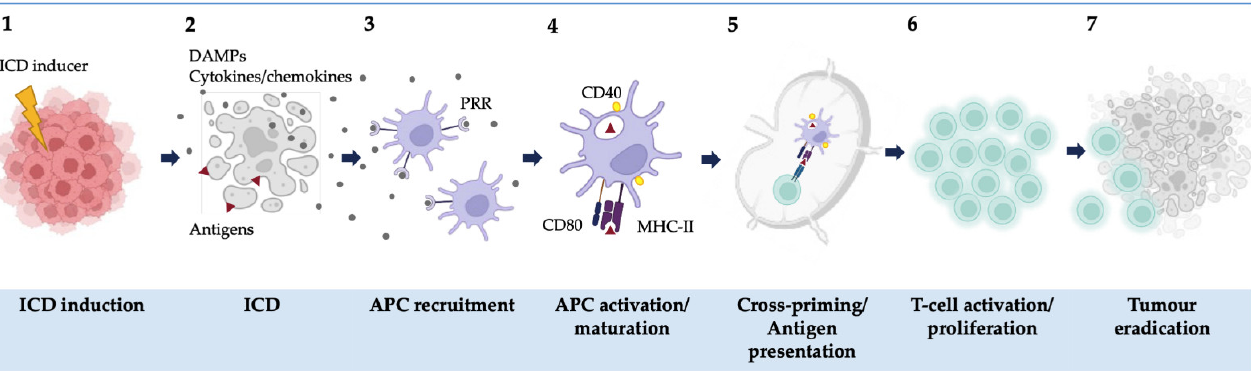
Figure 1. Immunogenic cell death (ICD): an overview. ICD can be induced in cancer cells (including by chemotherapeutics, radiation, photodynamic therapy) ( 1 ) and it is characterized by the expression of tumor-specific antigens (antigenicity) and the spatiotemporal emission of DAMPs, cytokines, or chemokines (adjuvanticity) ( 2 ). The combination of this antigenicity and adjuvanticity allows the recruitment of antigen-presenting cells (APCs) via their pattern recognition receptors (e.g., TLR4) ( 3 ). The APCs undergo activation and maturation which is associated with the expression of CD40, CD80, and MHC-II ( 4 ). After migrating to the local lymph nodes, the APCs present the antigens to the T-lymphocytes ( 5 ). The activated T-cells, mainly CD8 cytotoxic T-cells, proliferate ( 6 ) and elicit a tumor-specific immune response by migrating to the tumor site, causing tumor eradication ( 7 ) and T-cell memory formation.